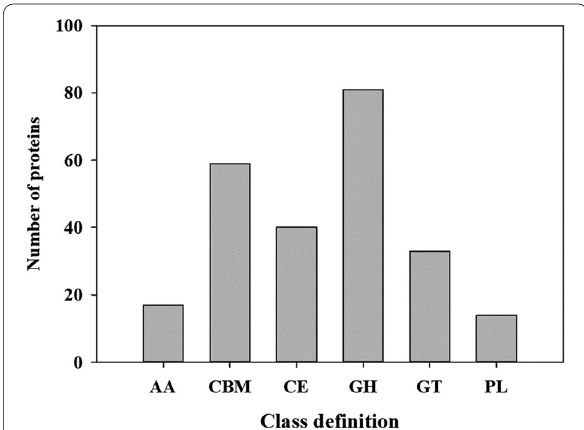
Fig. 6 Venn diagram illustrating the genes shared by the Microbulbifer sp. strains ALW1, S89, HZ11, and ATCC